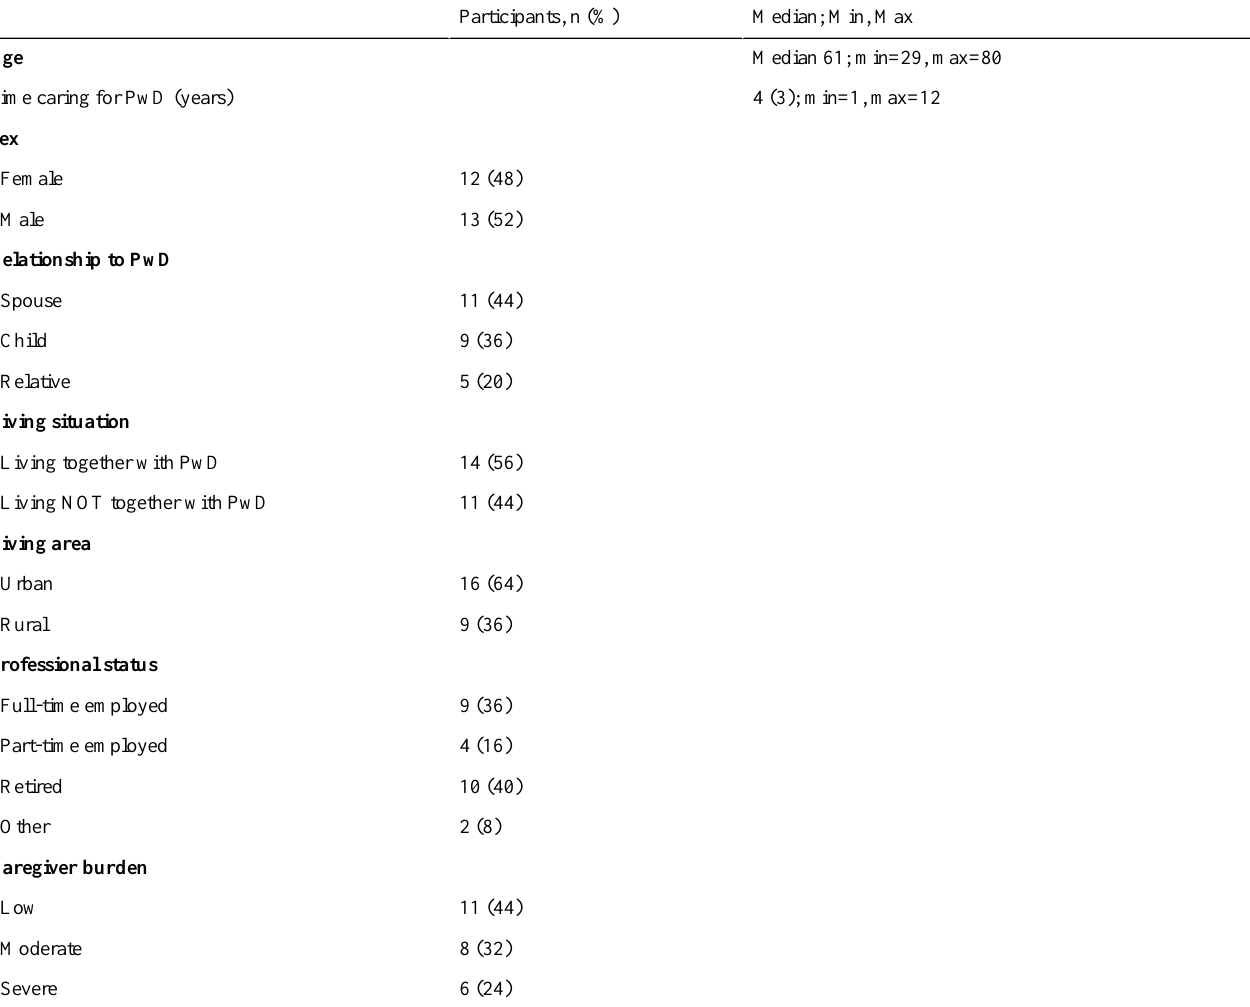
Table 1. Informal caregivers’characteristics